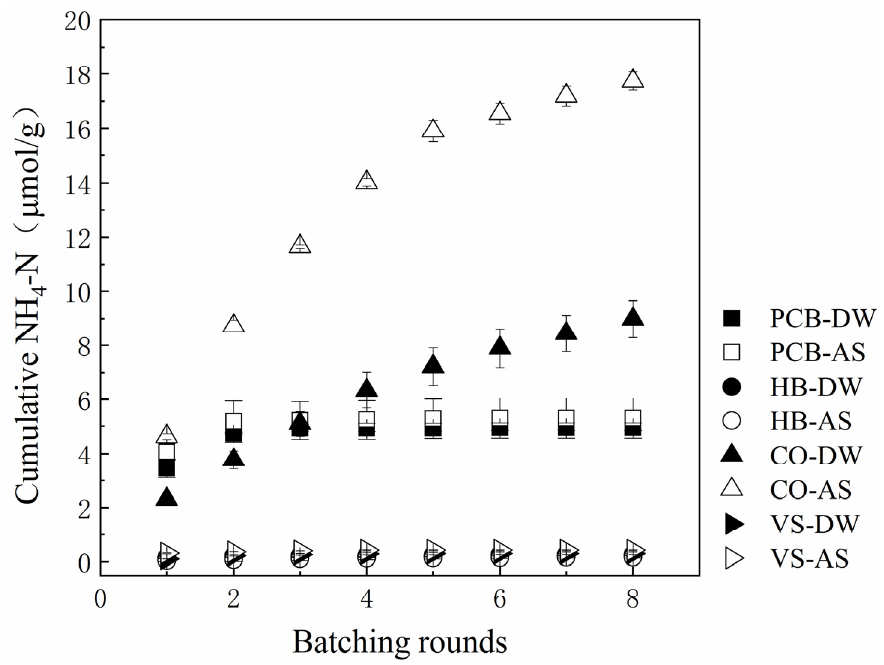
Figure 4. Cumulative ammonia nitrogen (NH 4 -N) leached from additive fillers (PCB, hardwood biochar (HB), compost (CO), and volcanic stone (VS)) in deionized water (DW) or artificial stormwater (AS).